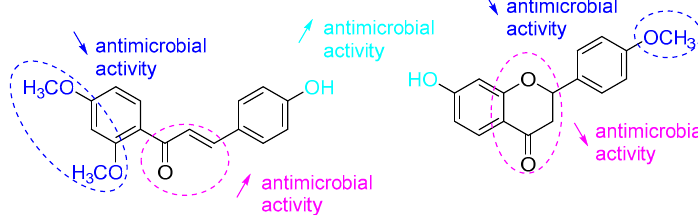
Figure 6. Structure/activity relationships established for antibacterial effect against B. subtilis .